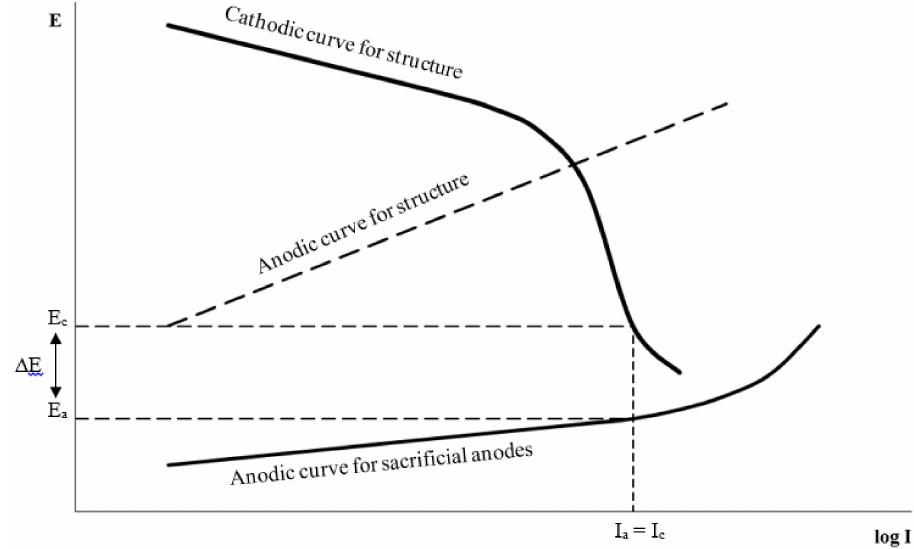
Figure 2. Evan’s diagram of a cathodic protection system with sacrificial anodes (adapted from Reference